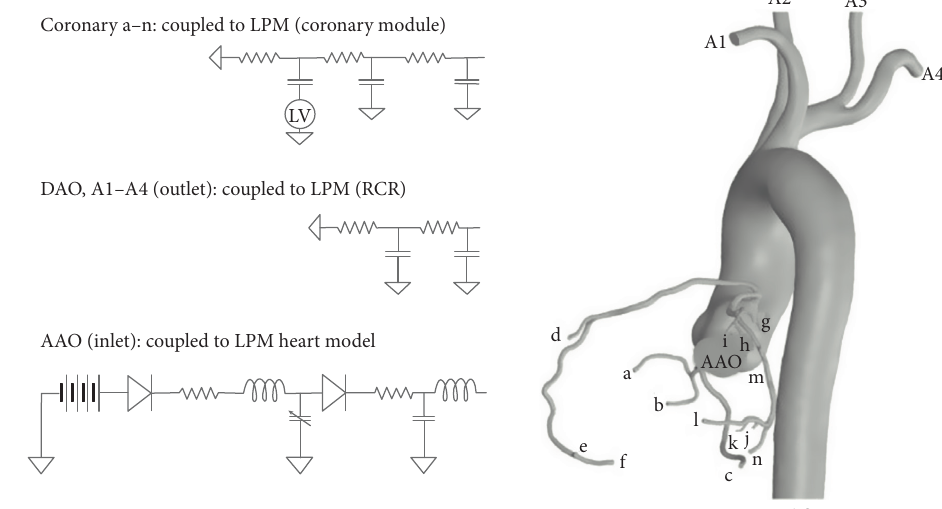
Figure 2: The construction of interfaces of the 0D/3D coupling model. In the coupled system, the coronary module of LPM is coupled with the coronary arteries of the 3D model, the LPM heart module is coupled with the aortic inlet of the 3D model, and the common artery LPM module (RCR) is coupled with other branch arteries of the 3D